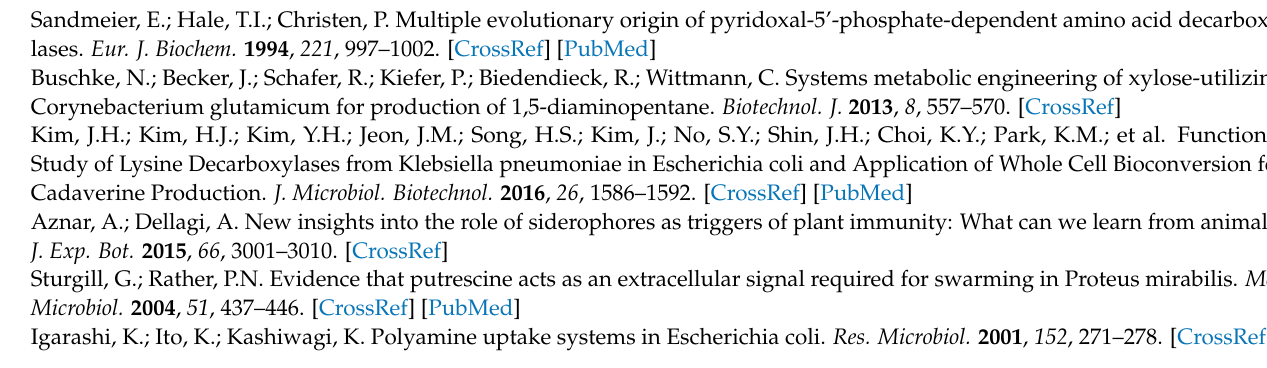
Supplementary Materials: Figure S1: The native PAGE and Western blot gels of SmcadA and its variants. M. Marker band showing 28.9 kDa Proteinase K and 66.4 kDa Bovine Serine Albumin as reference markers.1 is the native PAGE of the SmcadA WT as the control. 2-4 Ser512Ala and Arg595Lys bands, respectively B. western blot gel where M. Marker is the Takara Inc. Broad protein marker; 1 represented SmcadA WT, 2; the control, 3-5 represent the Ser512Ala and Arg595Lys mutants, respectively. The experiments were run at 60 V, for 8 h, without a reference marker protein. Figure S2: The Lineweaver-Burke linear plots. A-C. showed the fit for SmcadA WT, Ser512Ala and Arg595Lys mutants, respectively. The experiments were performed in a reaction mixture containing 500 mM sodium acetate buffer (350 µ L), different concentrations of substrate L-lysine (5–150 mM), 10 µ L cofactor PLP (0.25 mM) for 1 h. Figure S3: Image showing the first initial trajectory of cofactor PLP used during simulations. Figure S4: Image showing the second initial trajectory of cofactor PLP used during simulations. Figure S5: Solvation state of the protein-cofactor complex. The image shows the protein-cofactor complex after solvation in a triclinic dimensional box. Inset: The protein-cofactor after solvation and ionization. The blue spheres represent water molecules in the system, green the metal ions and the licorice sticks represent the cofactor PLP. The images were generated in VMD